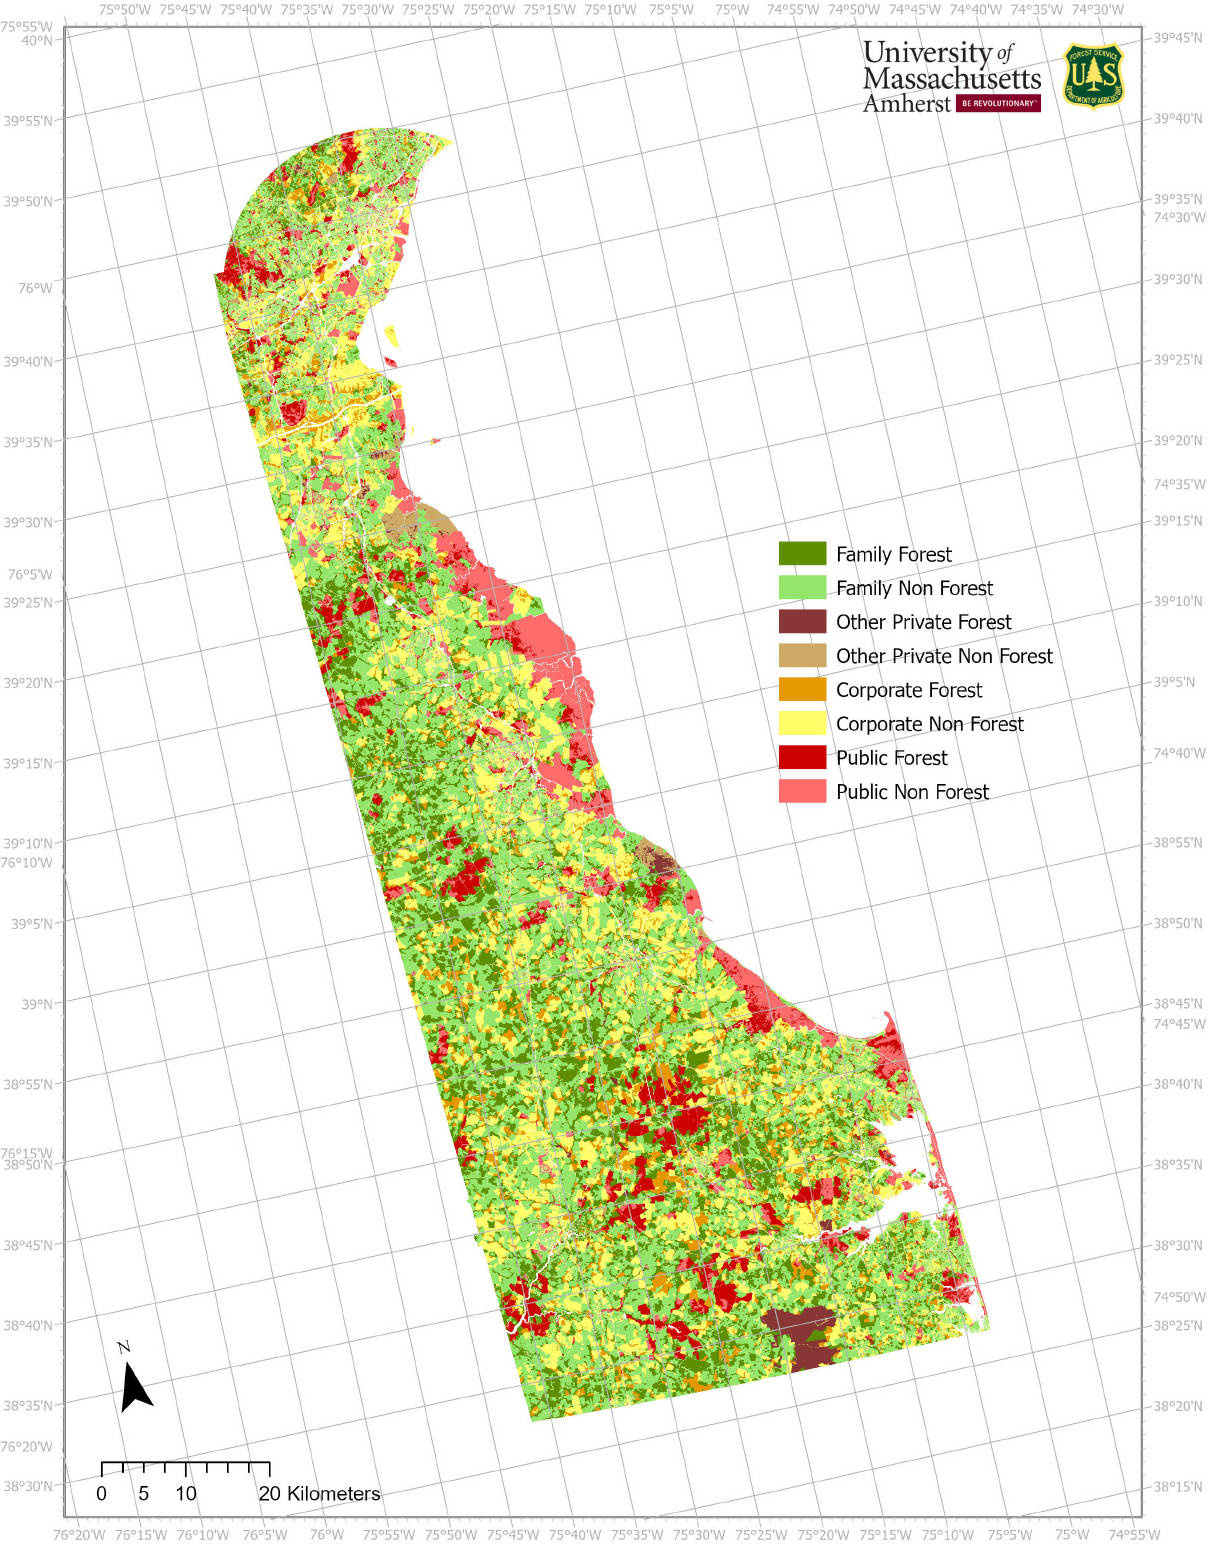
Frontiers in Forests and Global Change |